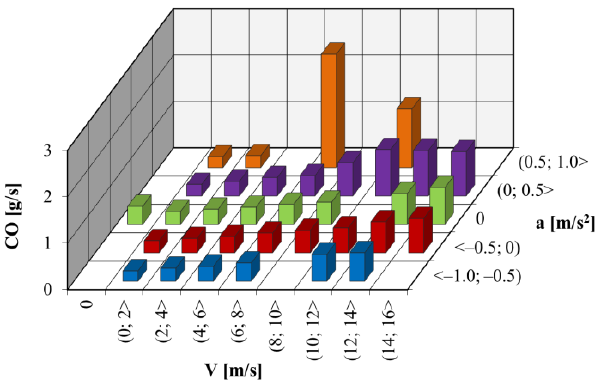
Fig. 11. CO exhaust emission intensity of the tested vehicle in speed and acceleration